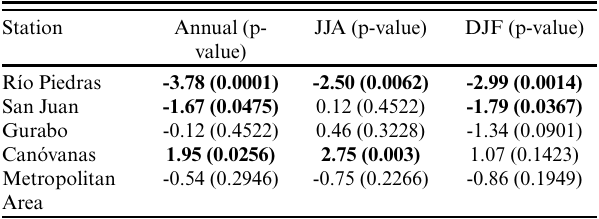
Table 6 . Mann Kendall trend analysis for consecutive periods of dry days (> 3 days < 8 days).